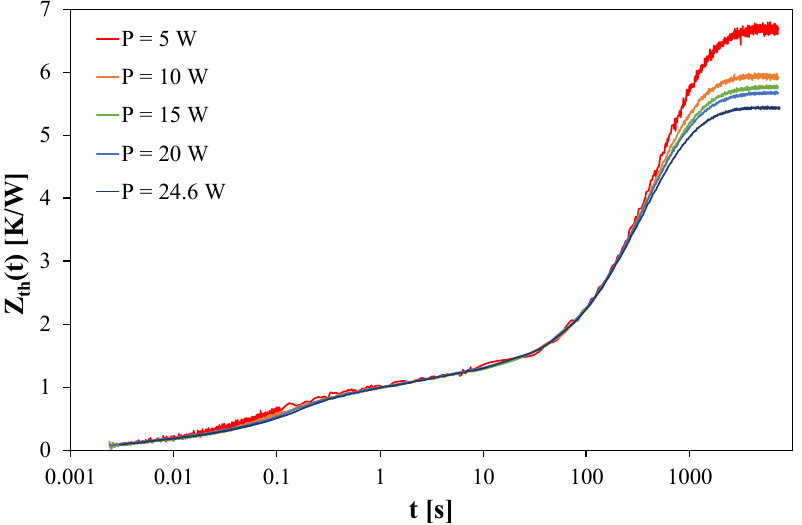
Figure 13. Waveforms of transient thermal impedance of transistor M 1 , measured using v DS as a TSP and the quadratic approximation of the thermometric characteristic.